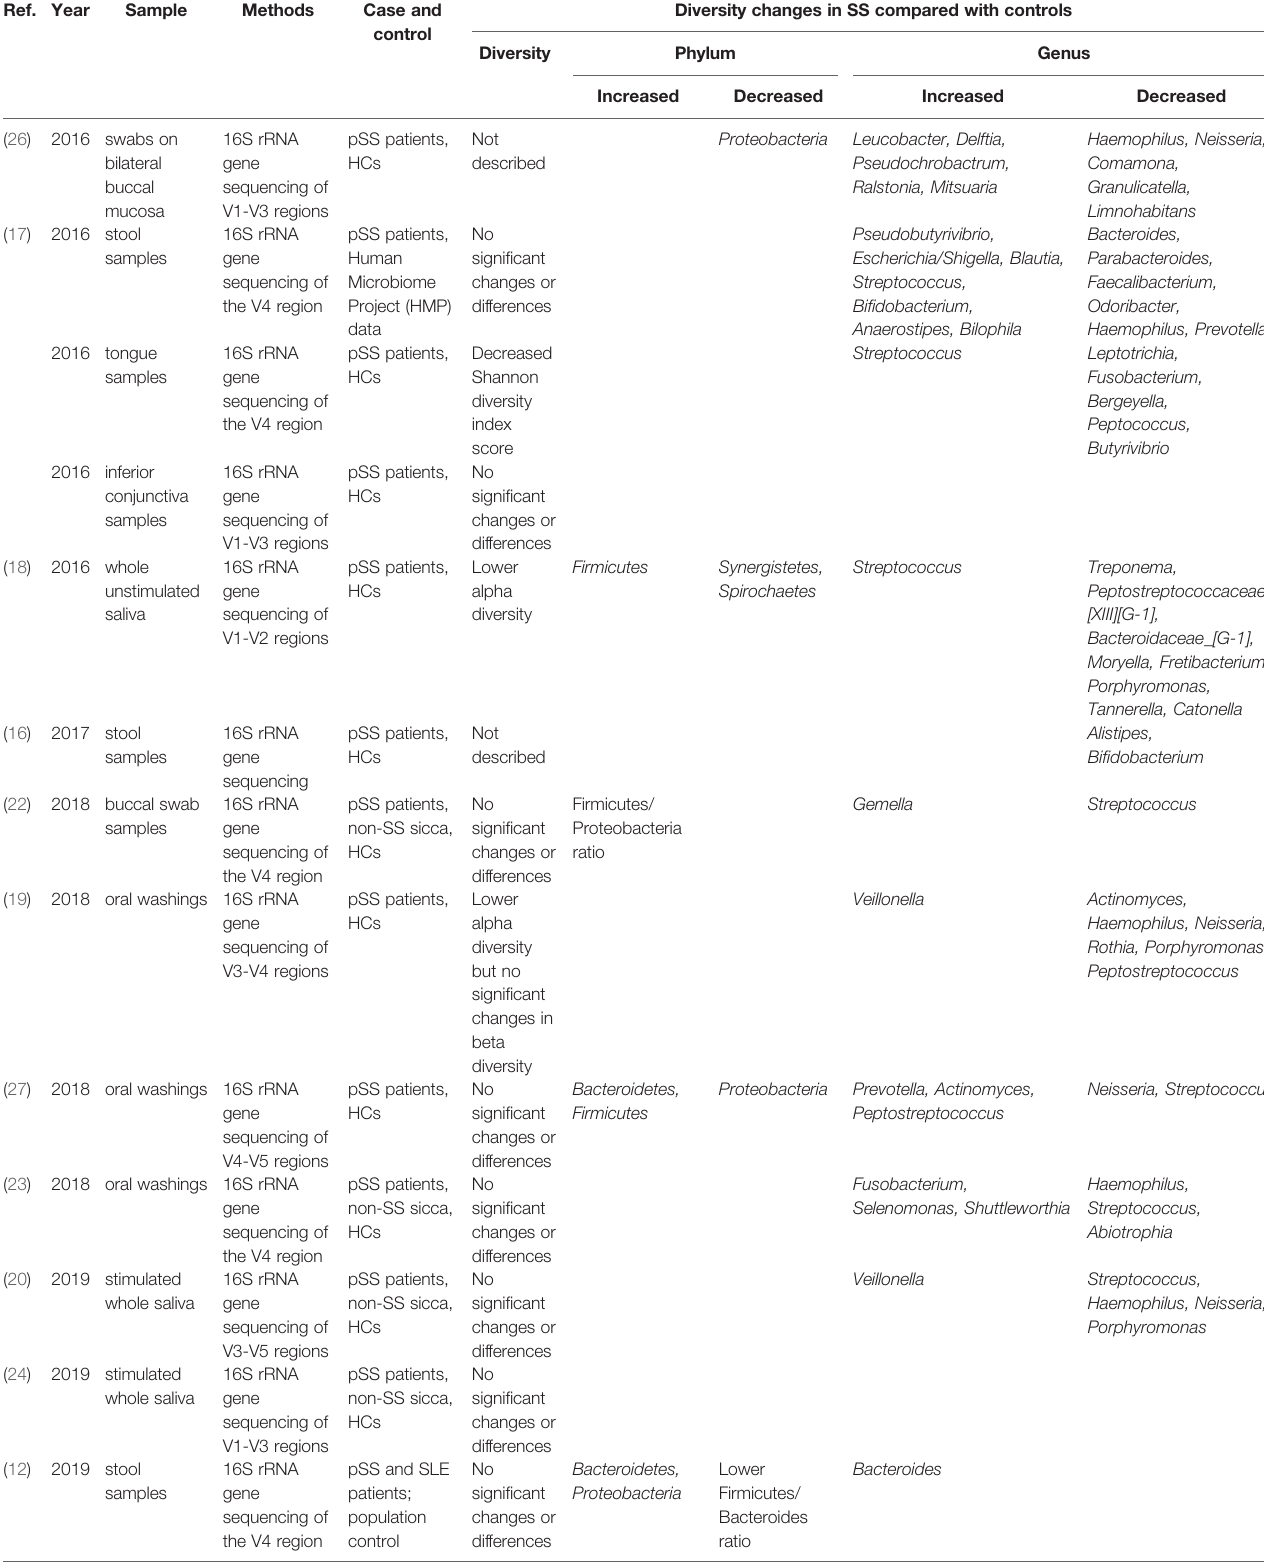
TABLE 1 | Microbiome studies of Sjögren ’ s syndrome. Ref.